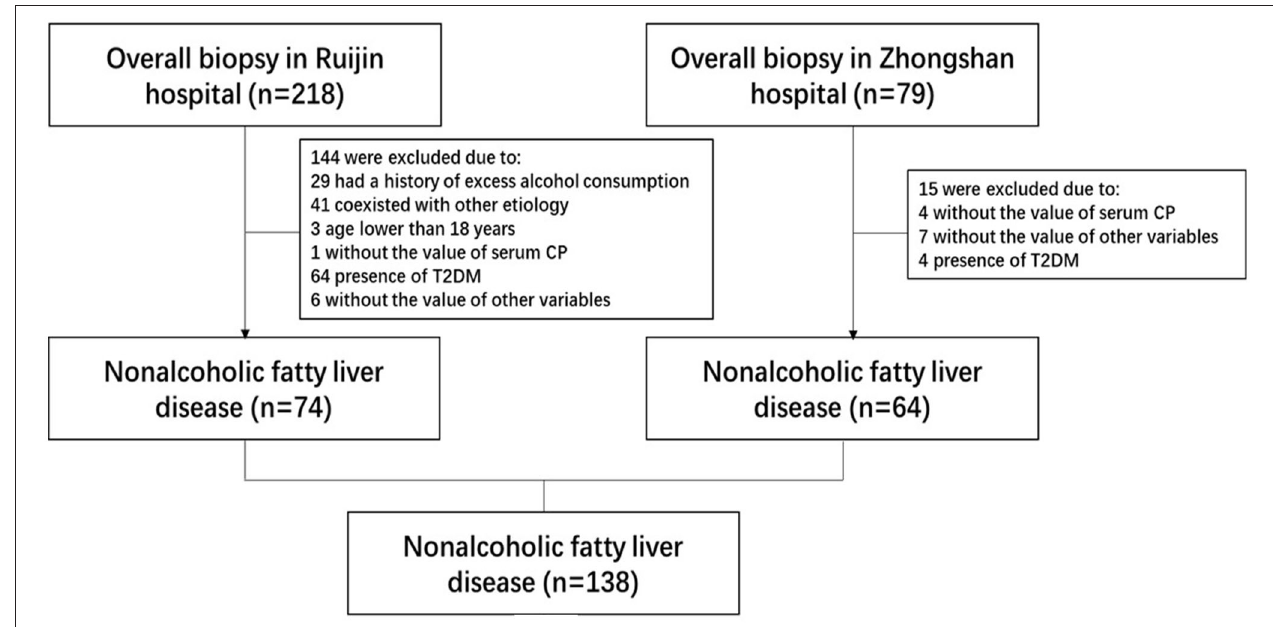
FIGURE 1 | The flow chart for patient inclusion.